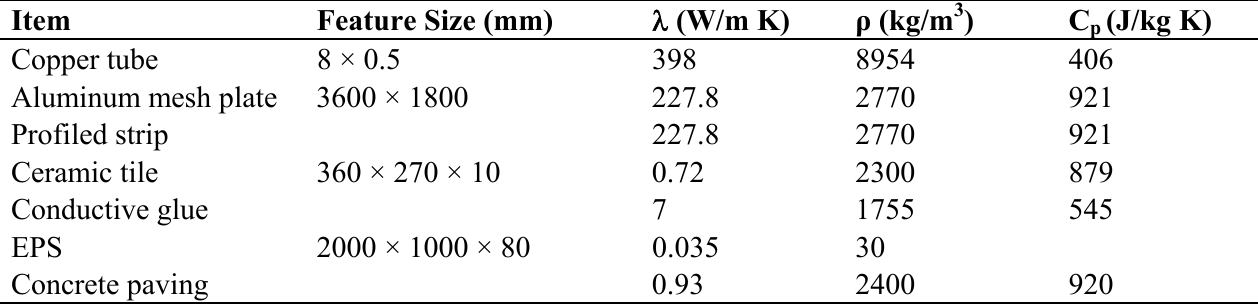
Table 1. The size and physical properties of the construction materials.